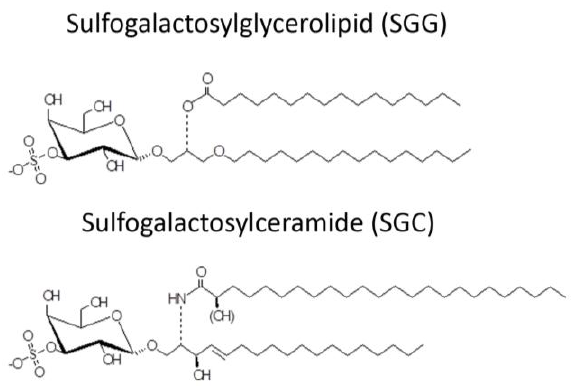
Figure 2. Chemical structure of sulfogalactosylglycerolipid (SGG) and sulfogalactosylceramide (SGC).